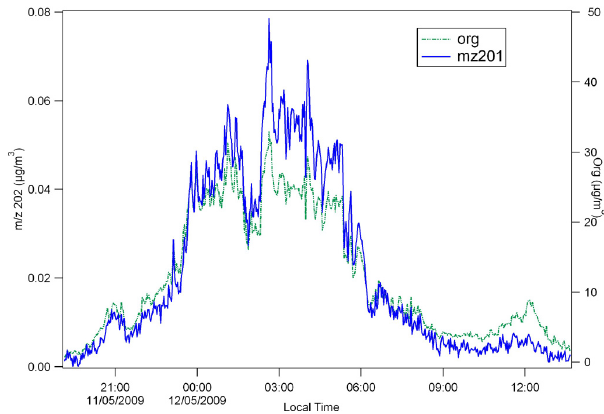
Fig. 4. The organic mass concentration, m/z 202 (mainly C 6 H 10 - Pyrene) concentrations as a function of local time during the burn- ing event and at noon the following